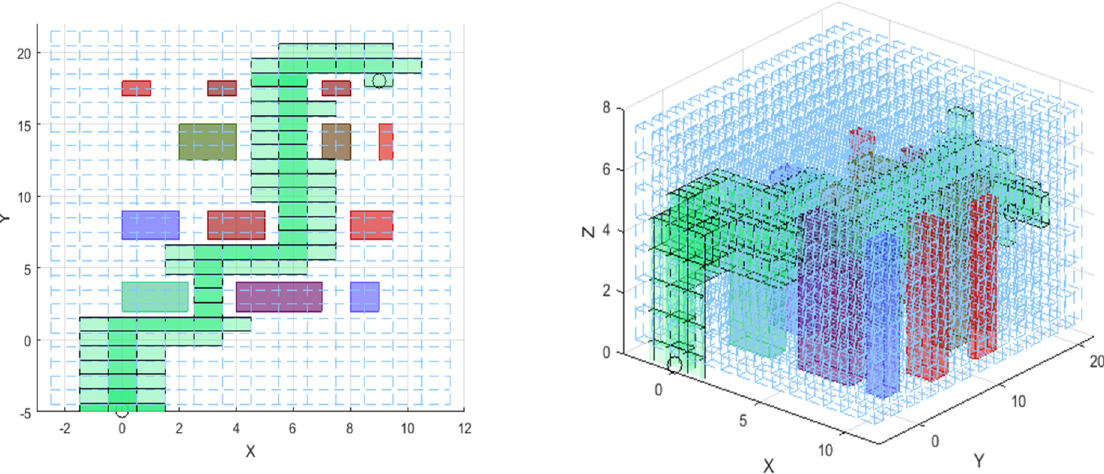
Figure 6. Augmented A* search in progress through the meshed environment (2D and 3D views).